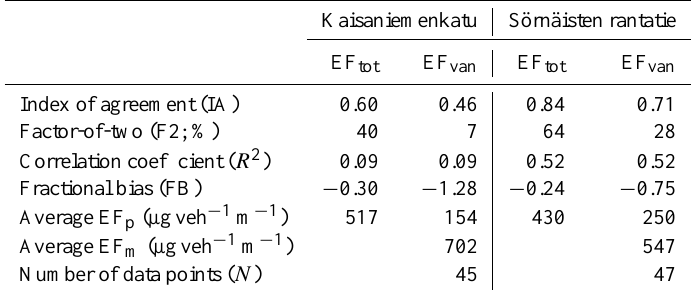
Table 4. The statistical analysis of the agreement of hourly average suspension emission factors for all traffic (EF tot ) and for a van (EF van ) , predicted by the NORTRIP model assuming case number 4, and measured in Kaisaniemenkatu and Sörnäisten rantatie in